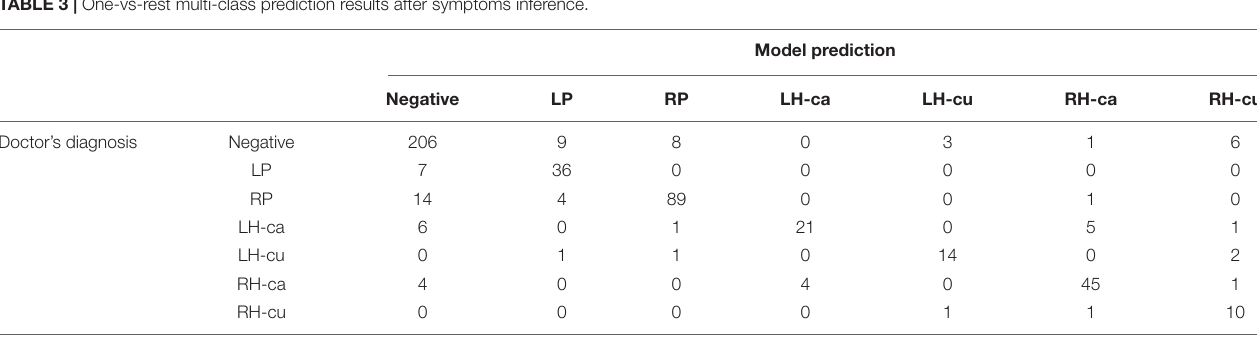
TABLE 3 | One-vs-rest multi-class prediction results after symptoms inference.